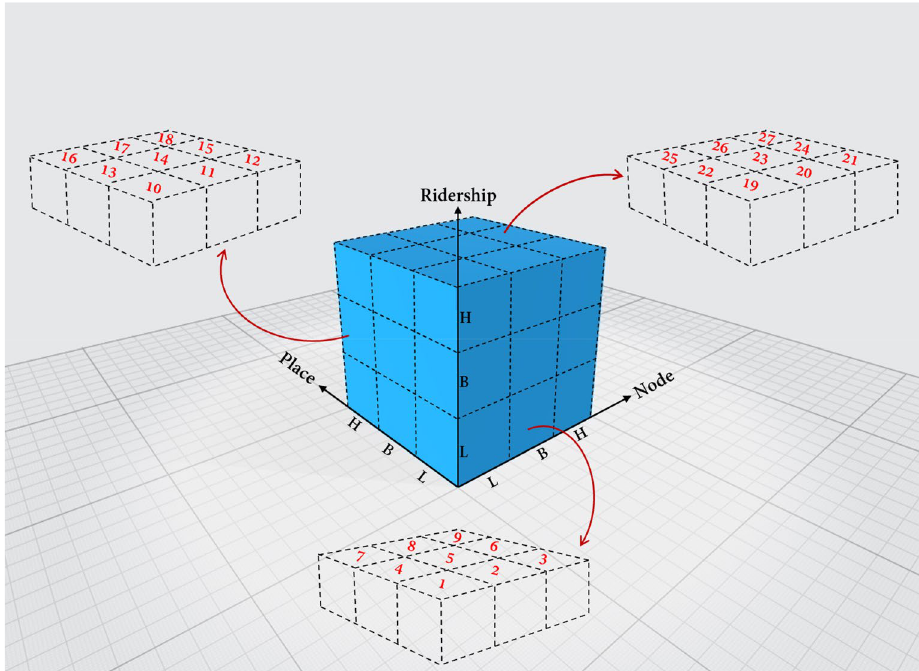
Figure 3. Low Balanced (LB), Balanced (B), and High Balanced (HB) classes of the Cube Method.